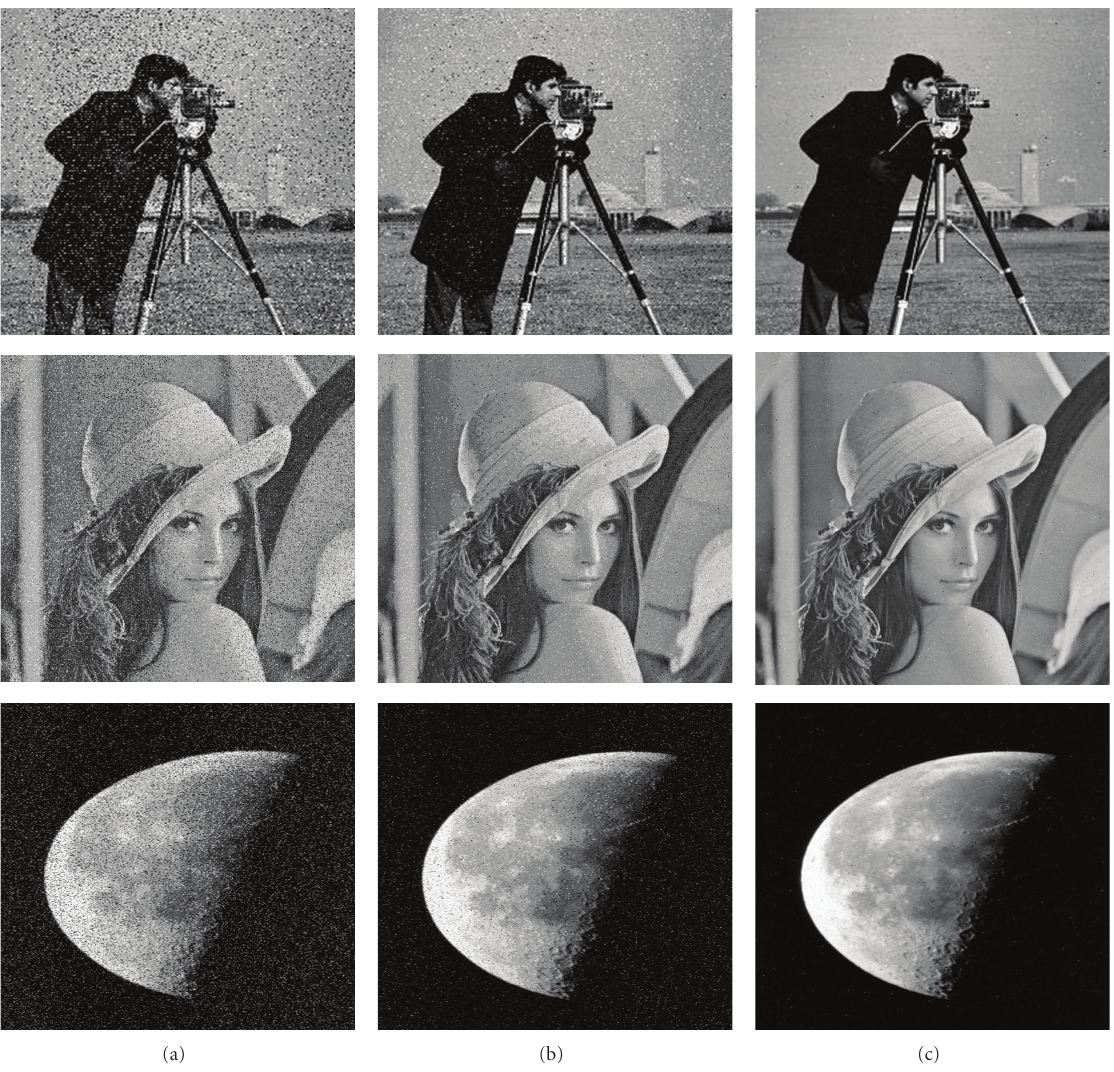
Figure 3: Image transmission using, (a) Conventional 16-QAM, (b) Power optimized 16-QAM, and (c) Jointly optimized power and modulation